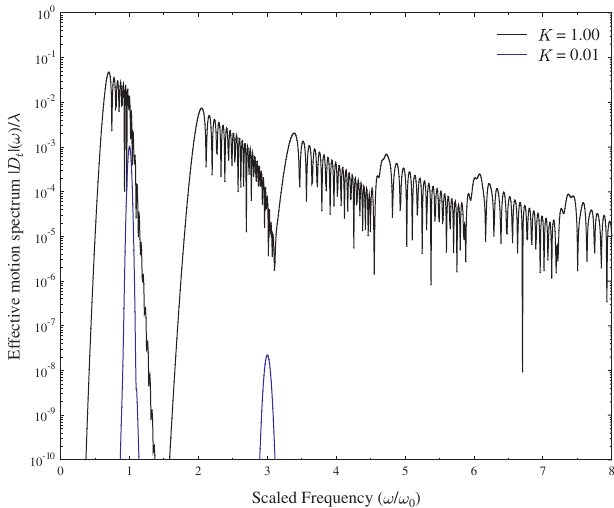
FIG. 3. (Color) Effective motion spectrum for Gaussian ampli- tude modulated